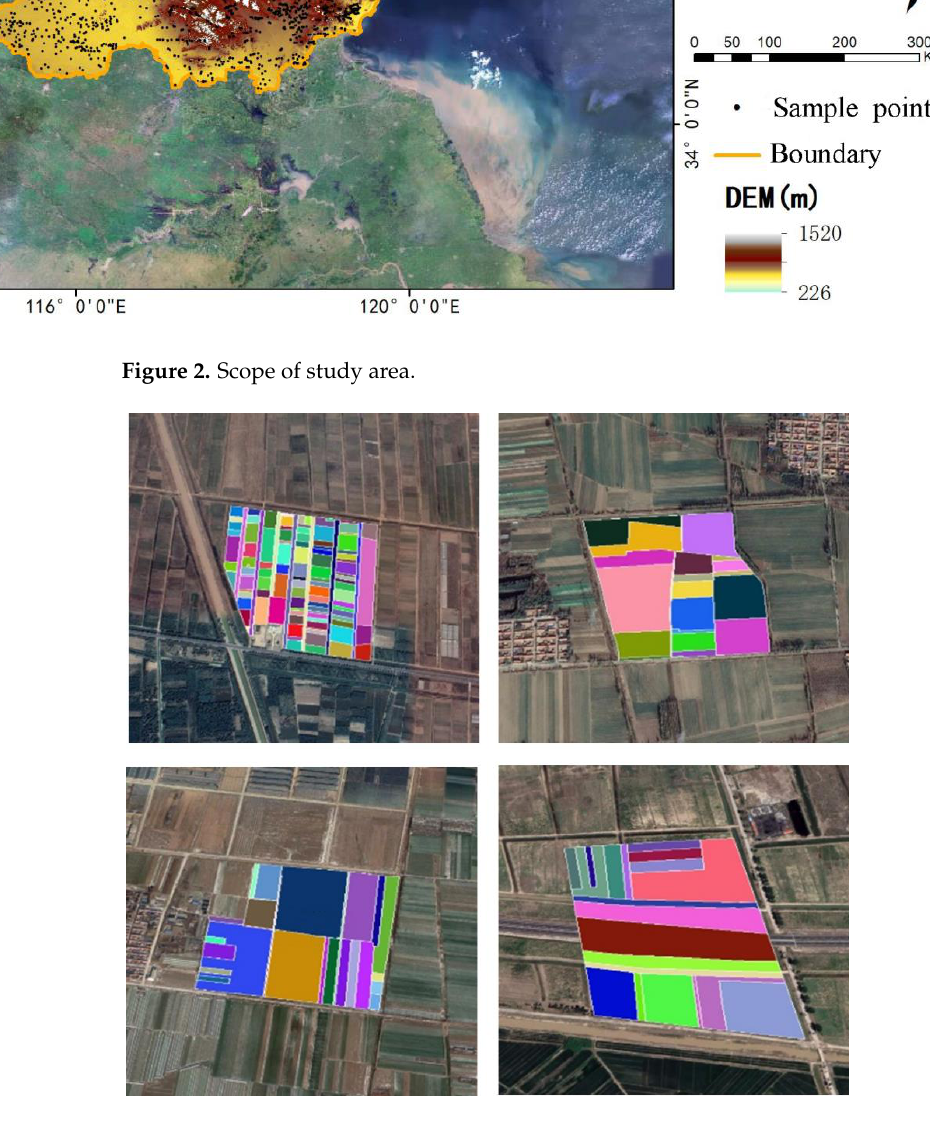
Figure 3. Field sample points. Table 2. Sample data information.